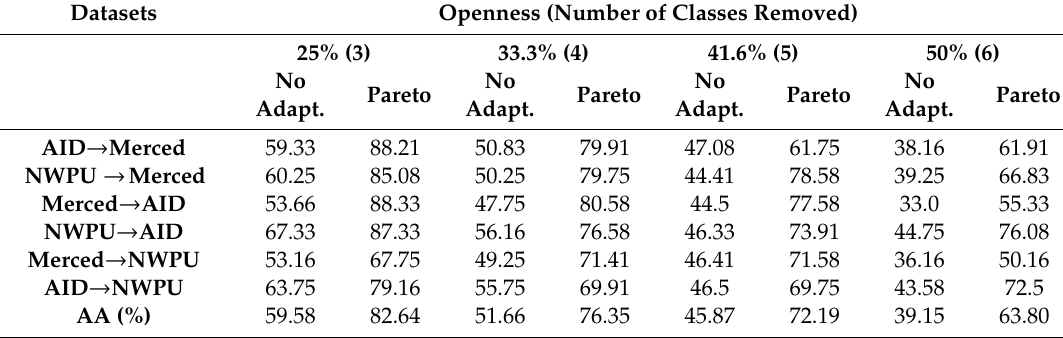
Table 8. Sensitivity analysis with respect to the openness for the VHR dataset. Results are expressed in terms of open set accuracy (OS) (%) and average accuracy (AA) (%).